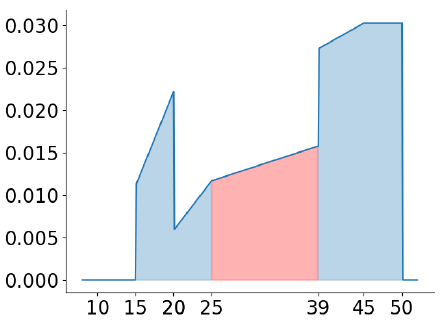
Figure 3. Piece of product F X · f Y used for join selectivity